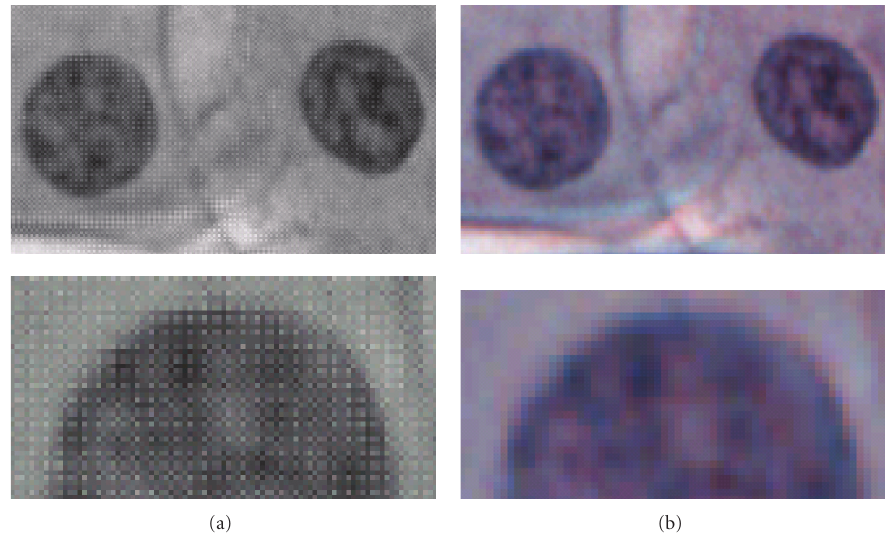
Figure 3: Optical system 15x NA = 0.75, taken with a CCD of 2.7 μ m pixels. The optical resolution of 0.45 μ m is sampled with 2.5 pixels, insu ffi cient considering the 4 pixels colour integration. Raw images (a) and their RGB transformation (b). In the raw image the 2G-R-B mosaic of the single-colour-chip is